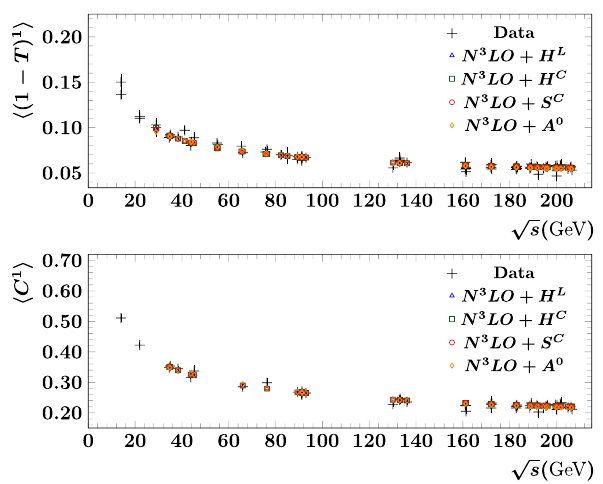
Fig. 3 Data and fits obtained with different hadronization models. All available data points from Table 2 are shown